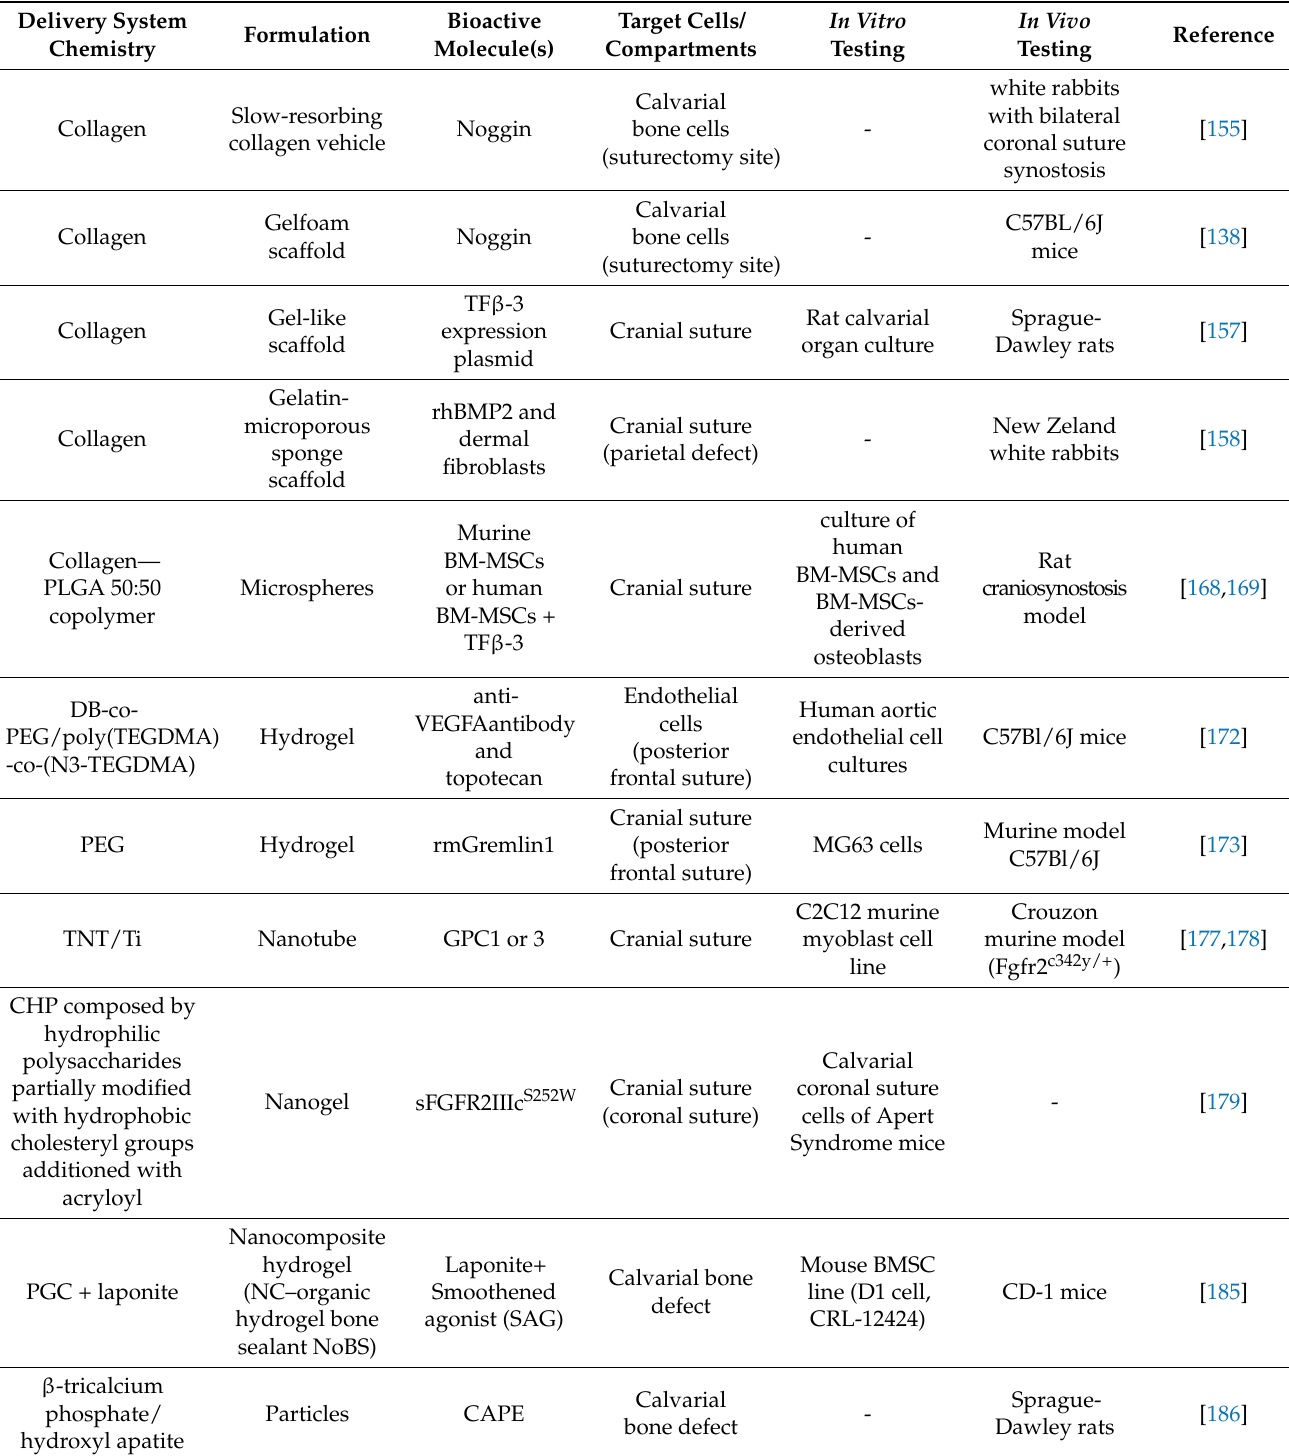
Table 5. Bioactive compounds and delivery